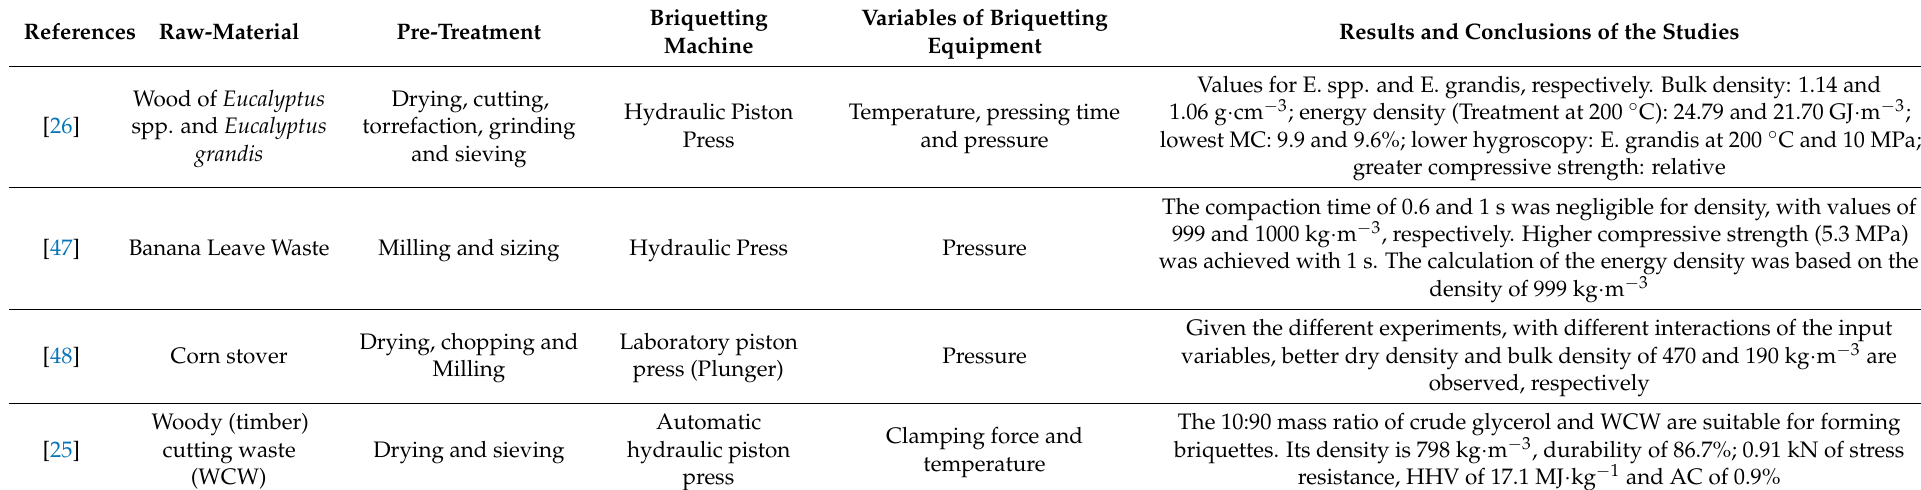
The 10:90 mass ratio of crude glycerol and WCW are suitable for forming briquettes. Its density is 798 kg · m − 3 , durability of 86.7%; 0.91 kN of stress resistance, HHV of 17.1 MJ · kg − 1 and AC of